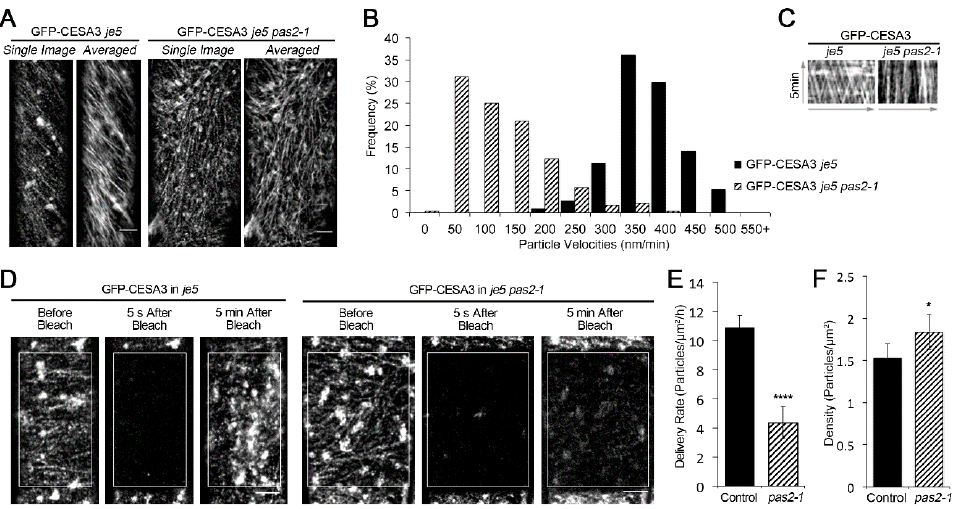
Figure 3. The pas2-1 mutant has altered cellulose synthase dynamics. ( A ) Single-frame and time-averaged images from a 5-min time series (see “Materials and Methods”) of epidermal cell in etiolated seedlings show the plasma membrane-localized GFP-CESA3 particles in the je5 and je5 pas2-1 mutant background. Bar = 5 μ M. ( B ) A histogram showing the distribution of GFP-CESA3 particle velocities. The mean velocity of GFP-CESA3 is 376.36 ± 55.35 nm/min ( n = 114, 9 cells) in je5 and 123.35 ± 79.89 nm/min ( n = 228, 23 cells) in je5 pas2-1 , respectively. ( C ) Kymographs displaying CESA3 particle movement from a single track in the averaged images. ( D ) Representative images displaying the plasma membrane CSCs before, 5 s after and 5 min after photo bleaching. FRAP was performed in the control (GFP-CESA3 in je5 ) etiolated seedlings and in pas2-1 mutants (GFP-CESA3 in je5 pas2-1 ). White boxes mark the bleached area. Bar = 5 μ M. ( E ). Quantifications of the delivery rate of CSCs from the FRAP assay described in D. **** p < 0.0001 ( n = 26 ROIs from 5 seedlings for je5 ; n = 31 ROIs from 7 etiolated seedlings for je5 pas2-1 ). ( F ) A graph of the average density of plasma membrane-localized GFP-CESA3 particles. * p < 0.01 (n = 8 cells from 5 seedlings for je5 and 17 cells from 9 seedlings for je5 pas2-1 ). Error bars represent SD.